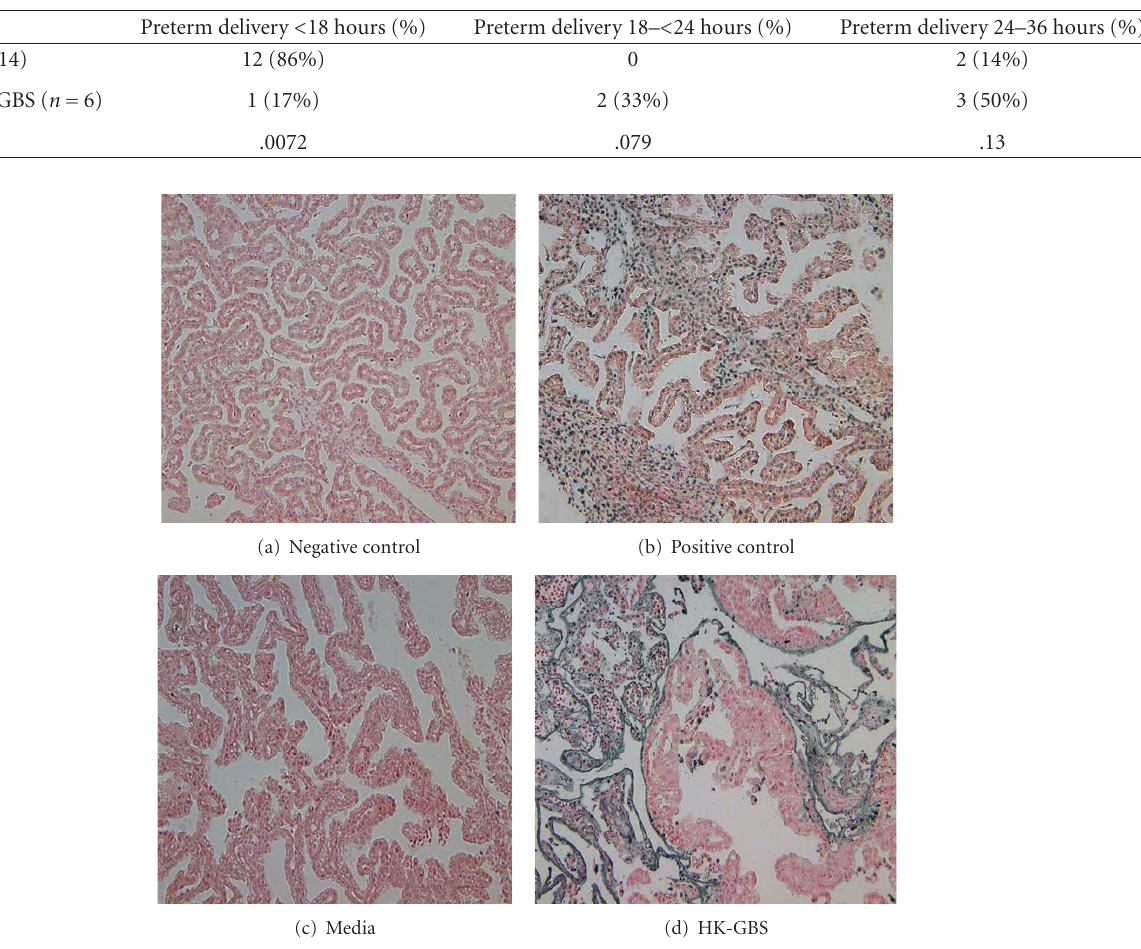
Figure 1: Intrauterine HK-GBS injection leads to TUNEL positive apoptosis in the membranes . Day 14.5 timed pregnant mice were injected with either HK-GBS (panel d) or PBS (a) and euthanized at 5 or 14 hours to isolate the placenta and membranes. The sections shown were obtained after 14 hours of stimulation. TUNEL positive apoptotic cells are stained black-brown. Slides treated with endonuclease served as a positive control (b); animals injected with media indicate baseline apoptosis levels (c). Data shown are representative of 3 separate